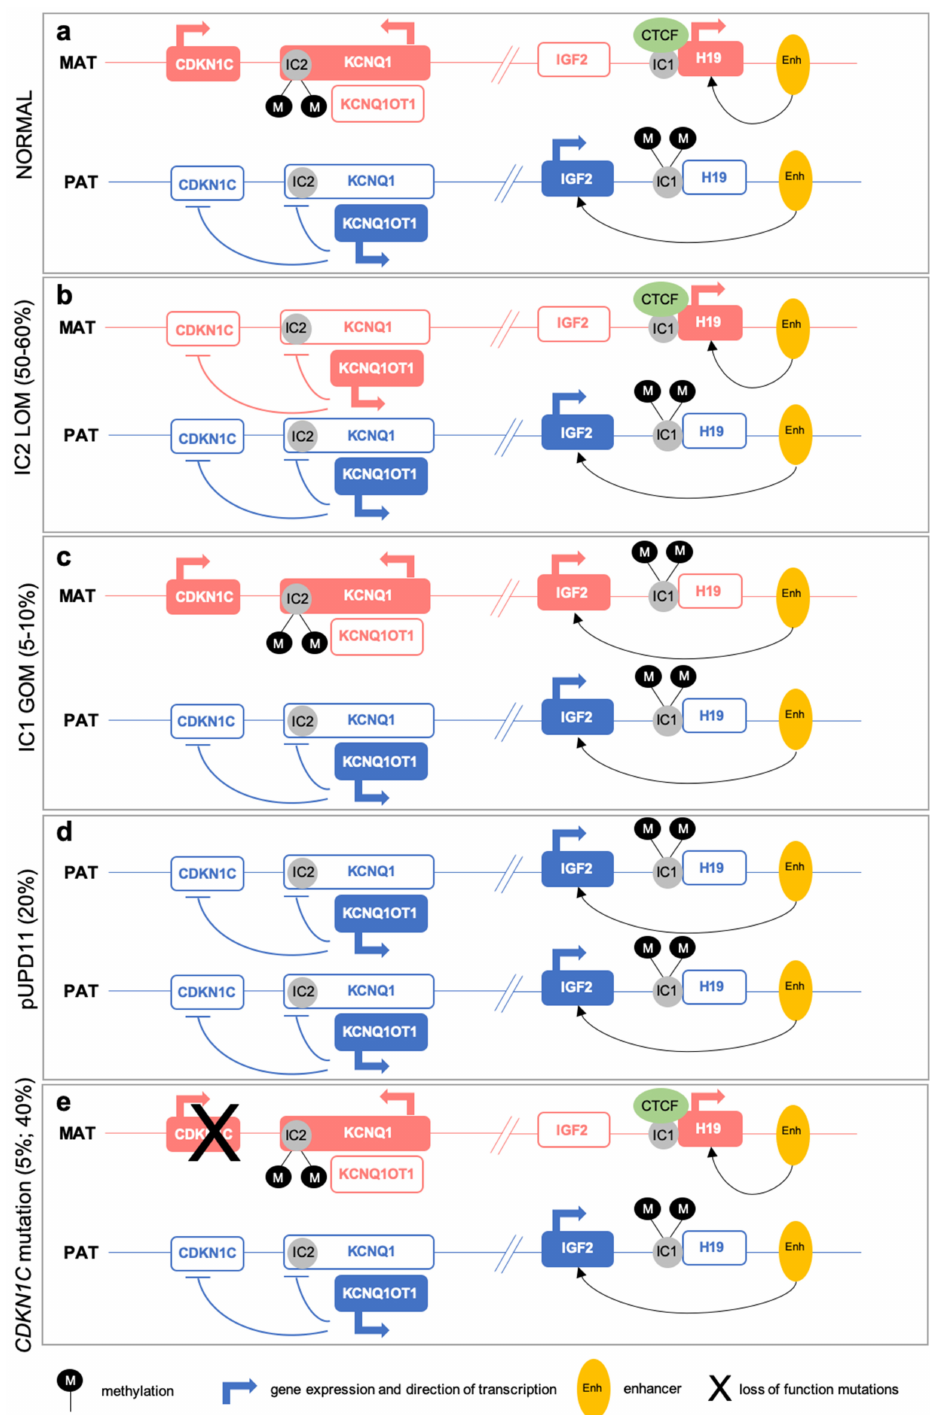
Figure 1. Schematic representation of genetic and epigenetic defects underlying Beckwith-Wiedemann syndrome (BWS). ( a ) Imprinting setting of IC1 and IC2 and expression of imprinted genes in the two 11p15 clusters on the maternal (red) and paternal (blue) allele in normal conditions. ( b ) IC2 LOM on the maternal allele leading to reduced expression of CDKN1C and KCNQ1 . ( c ) IC1 GOM at the maternal allele leading to biallelic expression of IGF2 and silencing of H19 . ( d ) pUPD11 resulting in the downregulated expression of CDKN1C and H19 and biallelic expression of IGF2 . ( e ) Maternal CDKN1C loss of function mutations resulting in absence of functional CDKN1C protein (adapted with permission from [18], Copyright (2021) John Wiley and